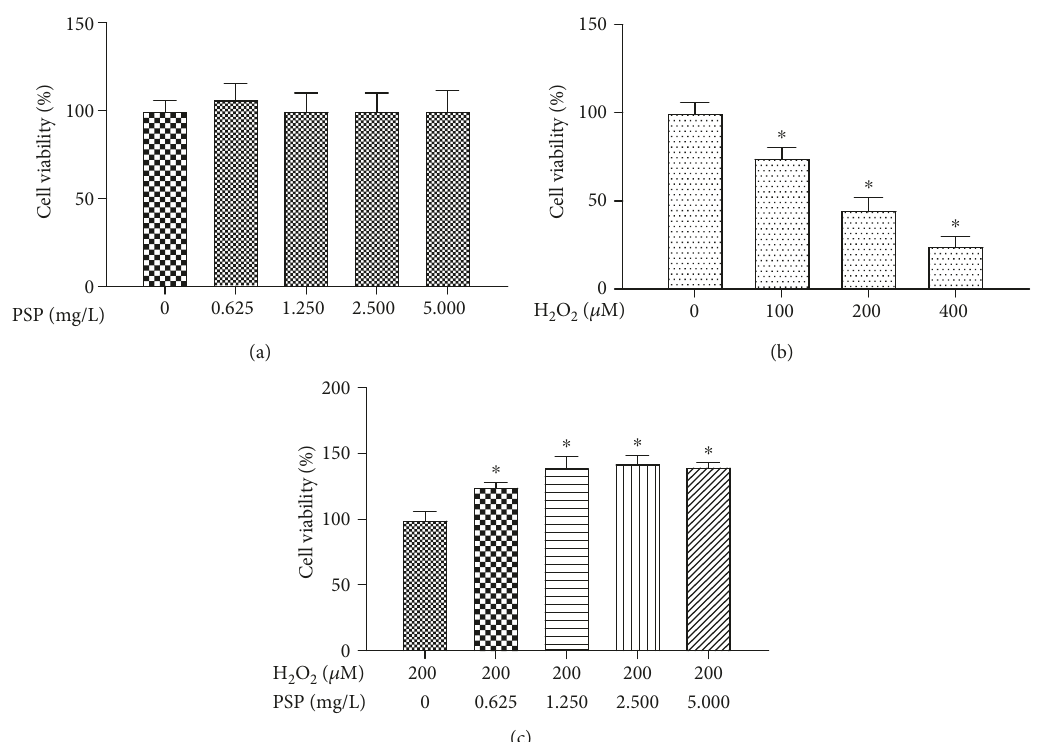
Figure 2: PSP inhibits H O -induced apoptosis in NPCs. (a) The toxicity of di ff erent concentrations of PSP on NPCs. ∗ P < 0 05 , compared 2 2 with the blank group. (b) The e ff ects on cell viability by di ff erent concentrations of H e ff ects of di ff erent concentrations of PSP on the cell viability a ff ected by 200 μ M H